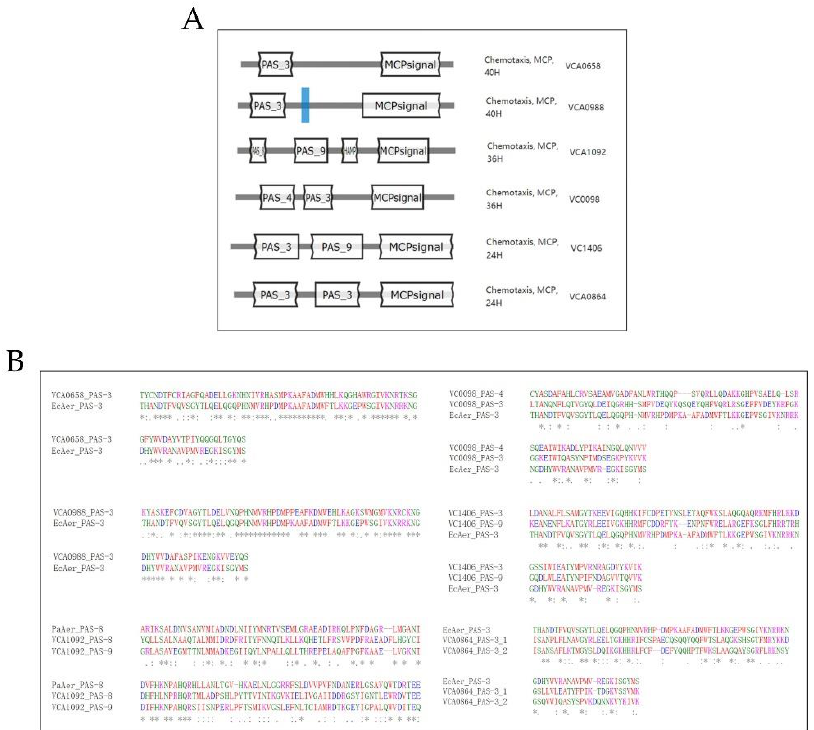
Figure 1. In silico analysis of the six MCPs with PAS domain in V. cholerae C6706 genome. ( A ) Predicted domain structure and type using MiTS 3.0. ( B ) Amino acid sequence alignment of aer homologs using MUSCLE. Residue conservation between groups are labeled with asterisk (*), colon (:), and dot(.) from high to low similarity.